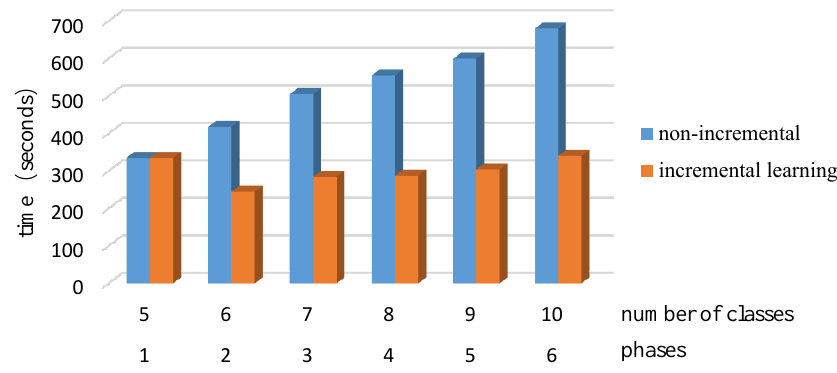
Figure 5. Comparison of non-incremental and incremental learning time